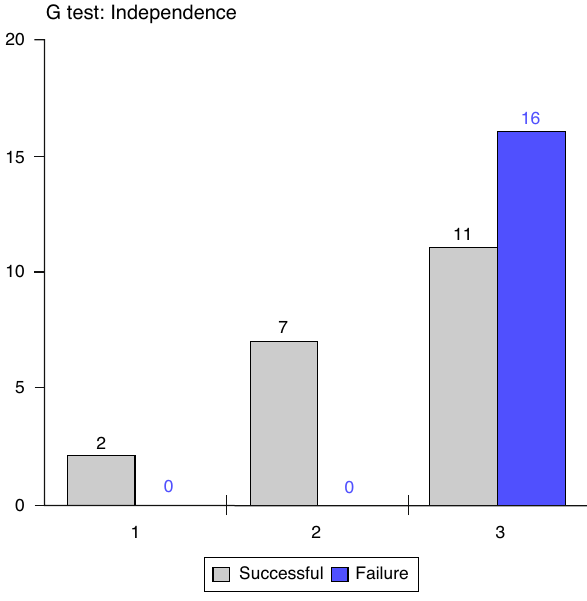
Figure 7 Correlation between the degree of stenosis accord- ing to Myer---Cotton and failures of balloon laryngoplasty ( p = 0.0015).